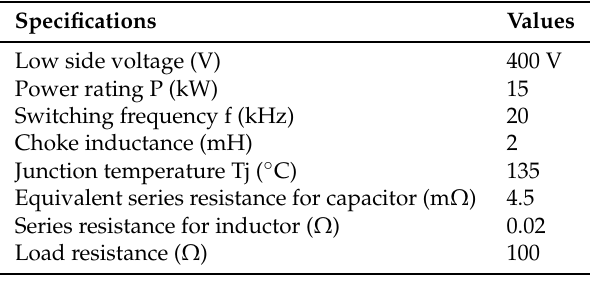
Table 4. Converter specifications.